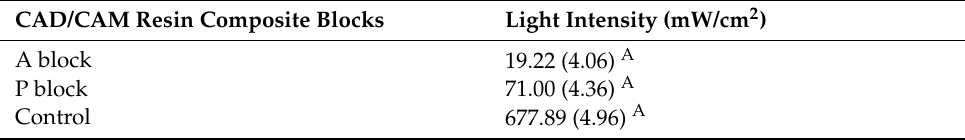
Table 4. Results of light intensity measurements